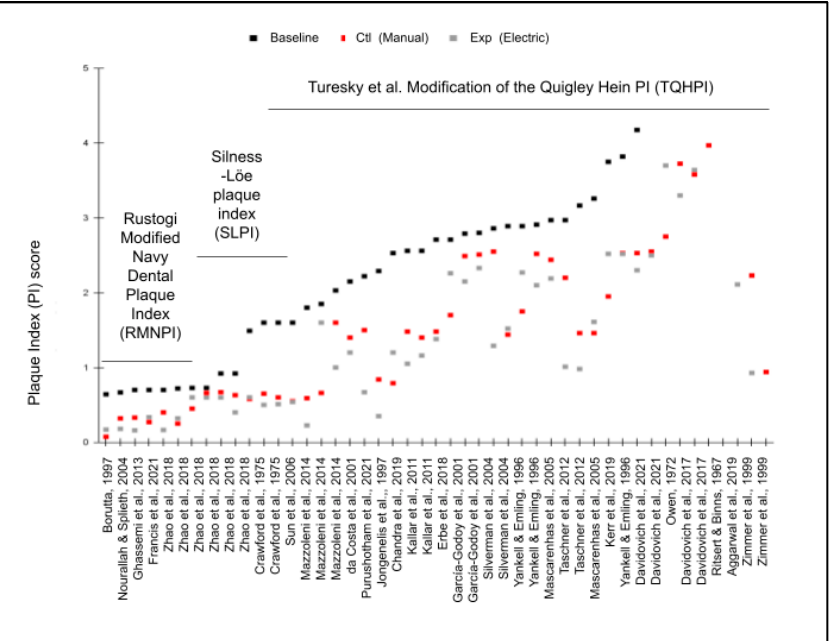
Figure 2. Graphic display of baseline and endpoint plaque indices. Baseline and endpoints from studies with Rustogi et al. Modified Navy Plaque Index (RMNPI, n = 8), Silness-Loe plaque index (SLPI, n = 6), and the Turesky et al. Modification of the Quigley Hein Plaque Index (TQHPI, n = 30) each demonstrated more significant reductions in the plaque index with the experimental variable (Exp) electric toothbrushes compared with the control (Ctl) variable manual toothbrushes [22–27,29–48]. Dent. J. 2023 , 11 , x FOR PEER REVIEW The data from the final articles included for pediatric, non-orthodontic studies were